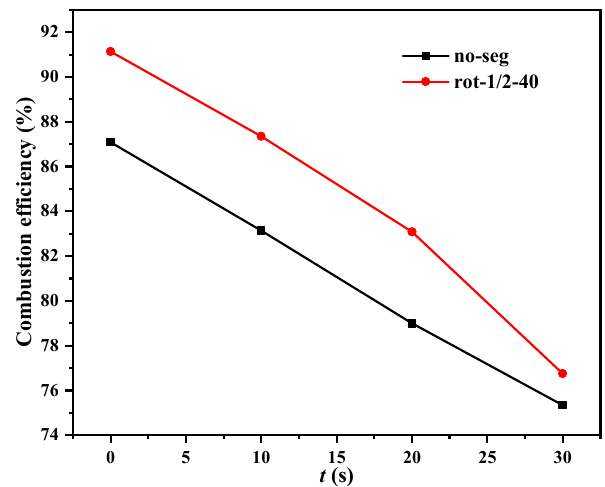
Figure 35. Combustion efficiency at different times.